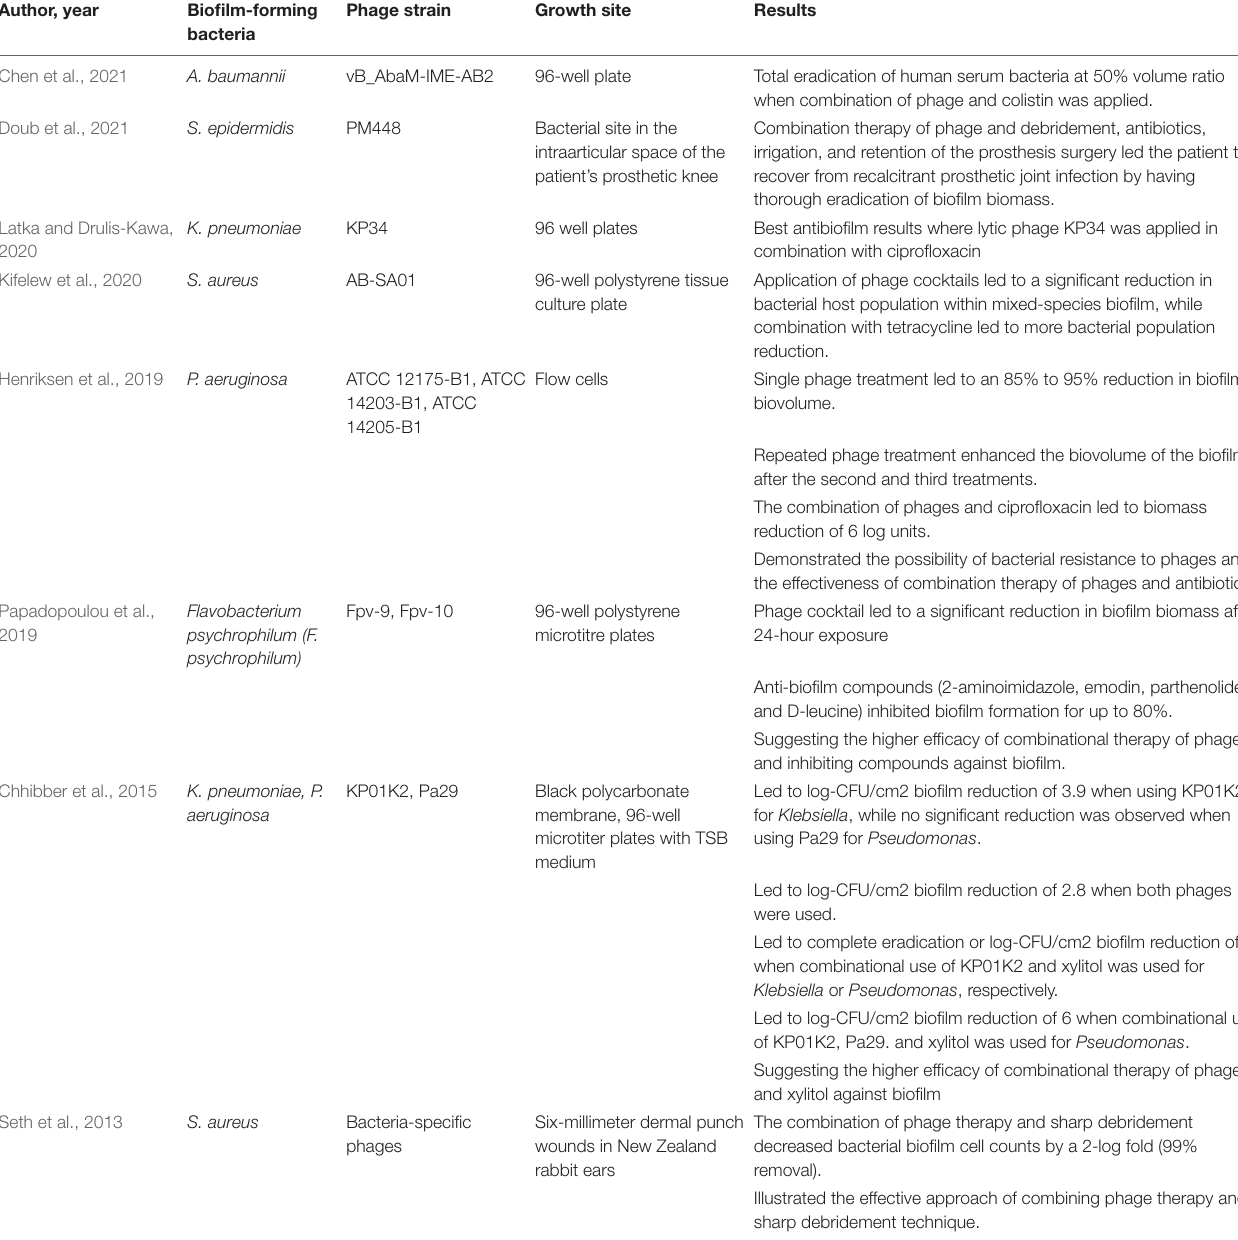
TABLE 4 | Anti-biofilm combination therapy